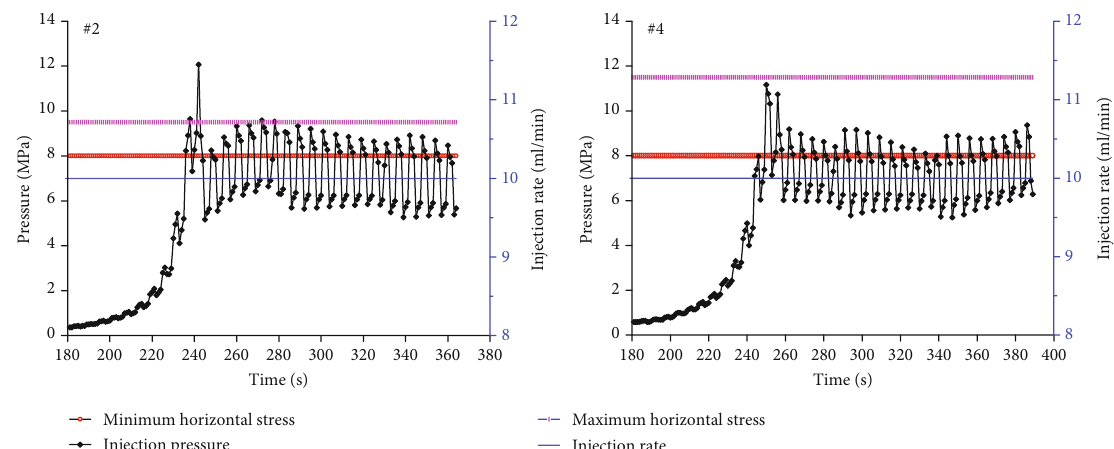
Figure 4: Injection pressure process of samples #2 and #4.